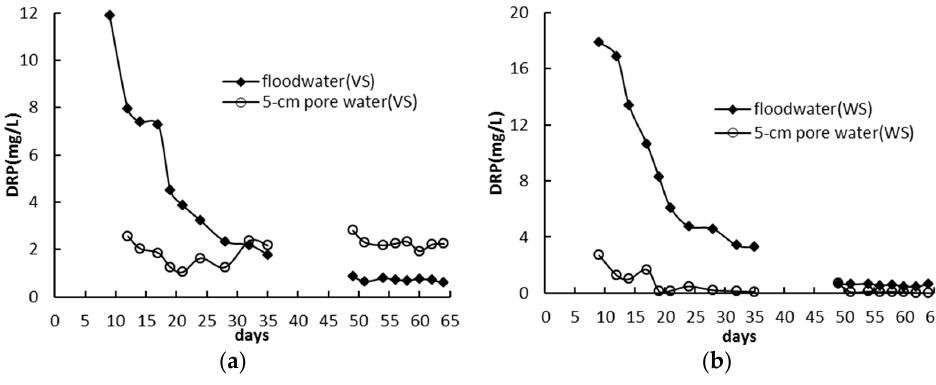
Figure 3. Changes of DRP in floodwater and surface pore water over time (( a ) VS; ( b ) WS; flooding period: days 0–35; draining period: days 36–48; reflooding period: days 49–64).